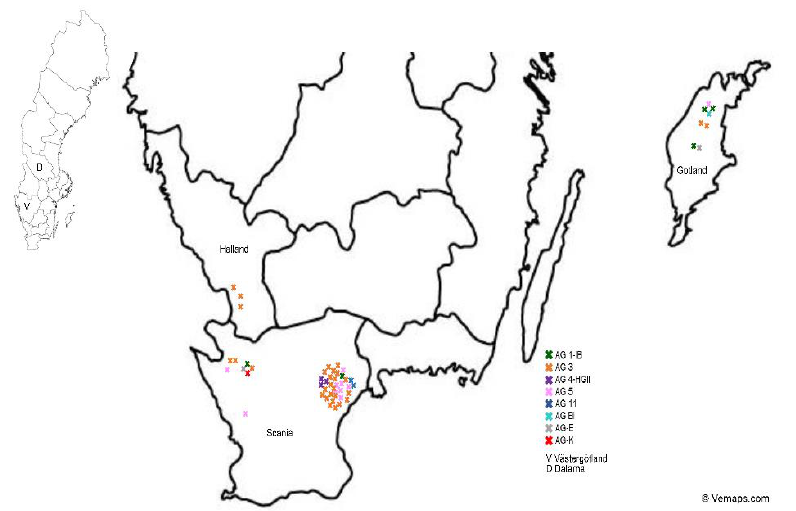
Figure 3. Map of Sweden showing the isolation sites and the different AGs of the Rhizoctonia isolates obtained from carrots, potatoes and black nightshade in different areas (V = Västergötland, D = Dalarna, Gotland, Halland and Scania).